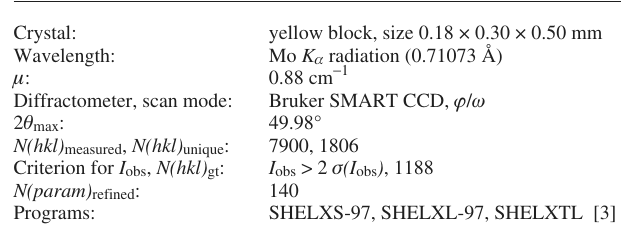
Table 1. Data collection and handling.